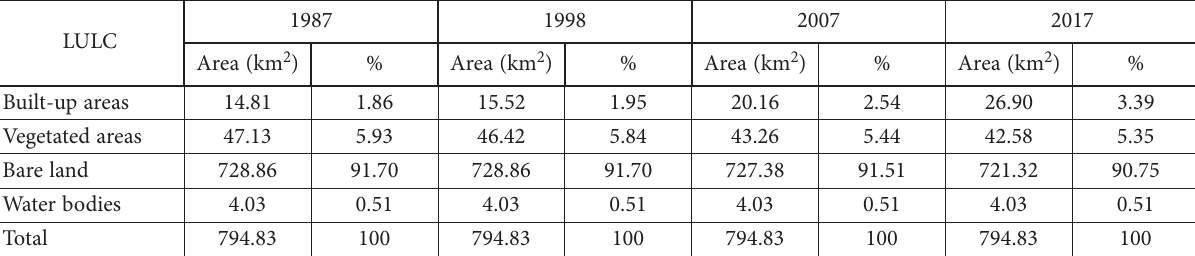
Table 4. Area and percentage of different land use classes from 1987 to